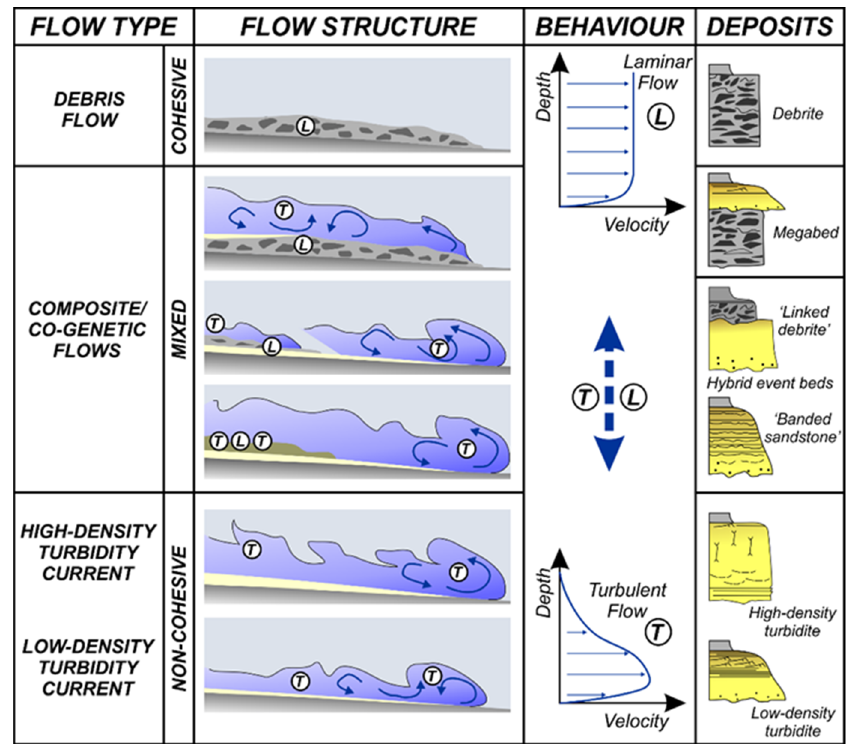
Figure 1. Haughton et al. (2009) classification scheme for event beds emplaced by a wide variety of subaqueous sediment gravity flows emphasizing that many of the deposits are composite or transitional in character, lying between end-member non-cohesive (turbulent) and cohesive (laminar) flow states. Reprinted/adapted with permission from Ref. [32], 2009, Elsevier.